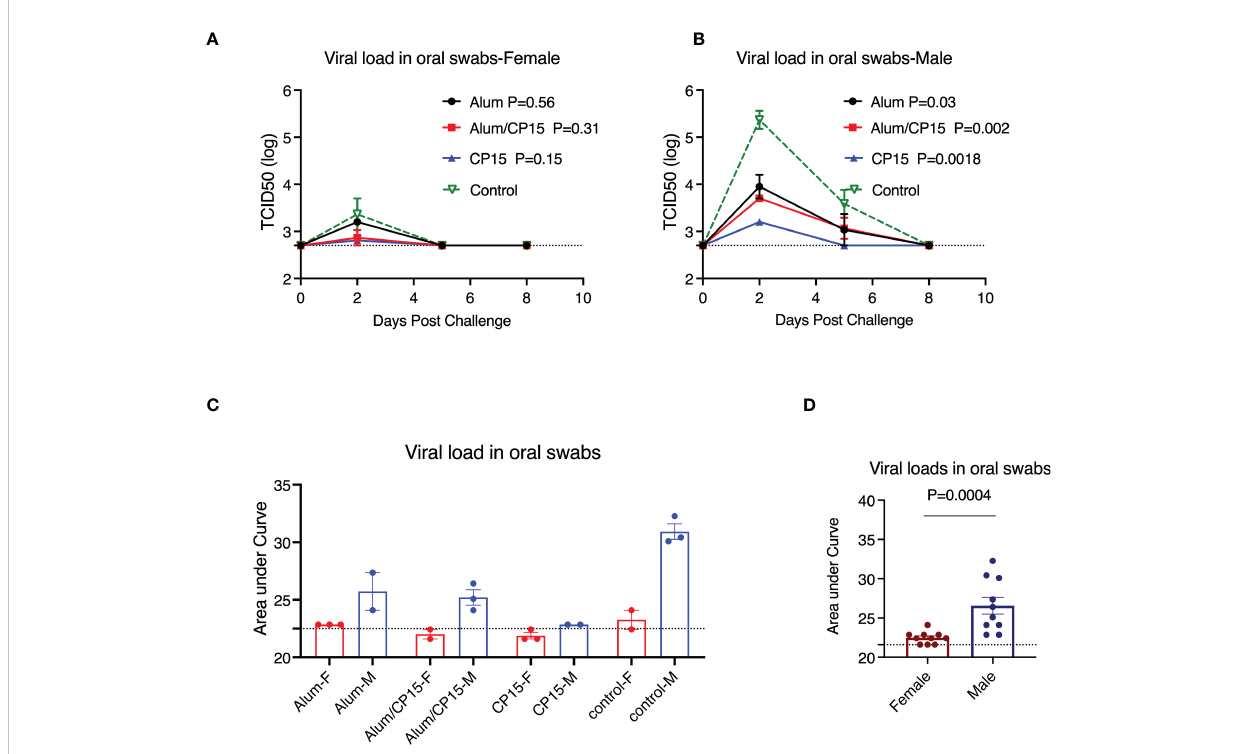
FIGURE 3 Sex difference in viral load reduction after challenge with SARS-CoV-2 WA strain in Syrian golden hamsters. (A, B) . Kinetics of viral load reduction in vaccinated and naïve female (A) and male (B) hamsters. (C, D) . Comparisons of area under curve of viral load reduction between female and male hamsters after SARS-CoV-2 WA strain infection. Each symbol represents one animal in (C, D) . Two-way ANOVA analyses were used to compare the vaccinated groups and control group. Mann-Whitney test was used to compare the females and males. Dashed lines show the detection limit. Mean ± SEM are